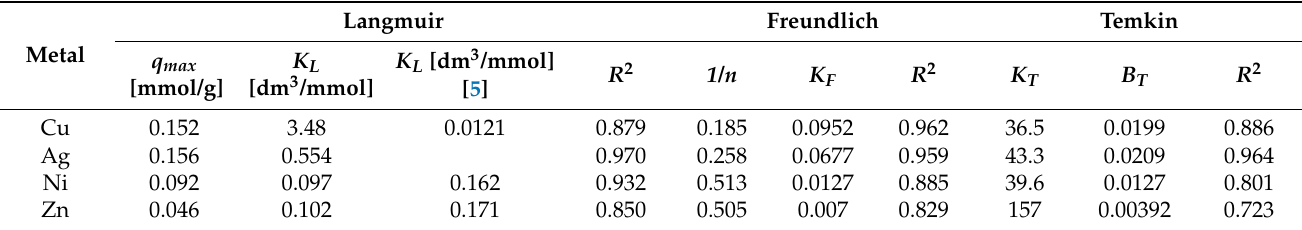
Figure 5. The adsorption isotherm of metal on amidoxime-chitosan hydrogels (gel dosage: 0.3 g, pH: 6, agitation speed: 100 rpm, temperature: 30 °C). Table 1. Adsorption isotherm